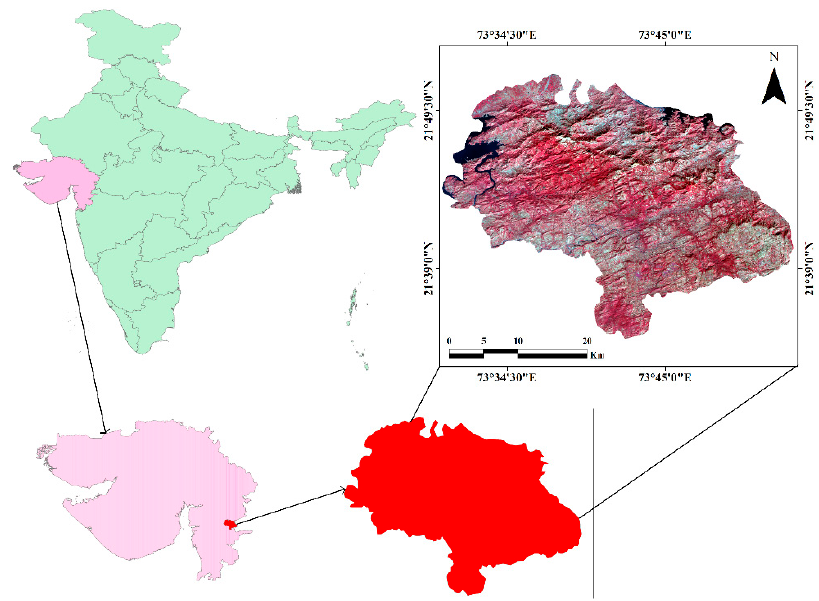
Figure 1. Map depicting the study area (shown in red color).